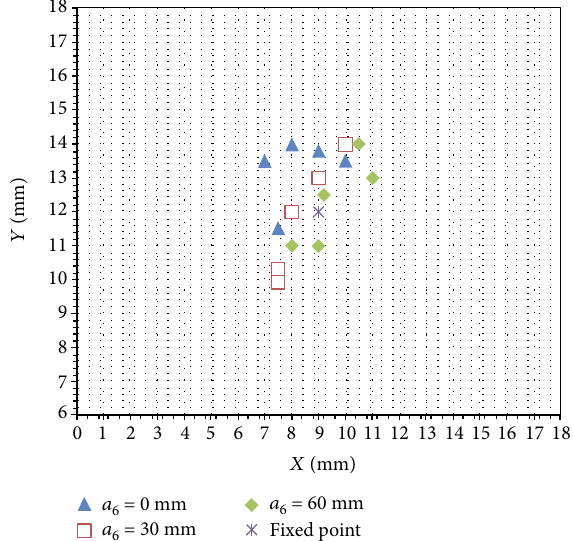
Figure 14: Remote center point error under the motion of azimuth